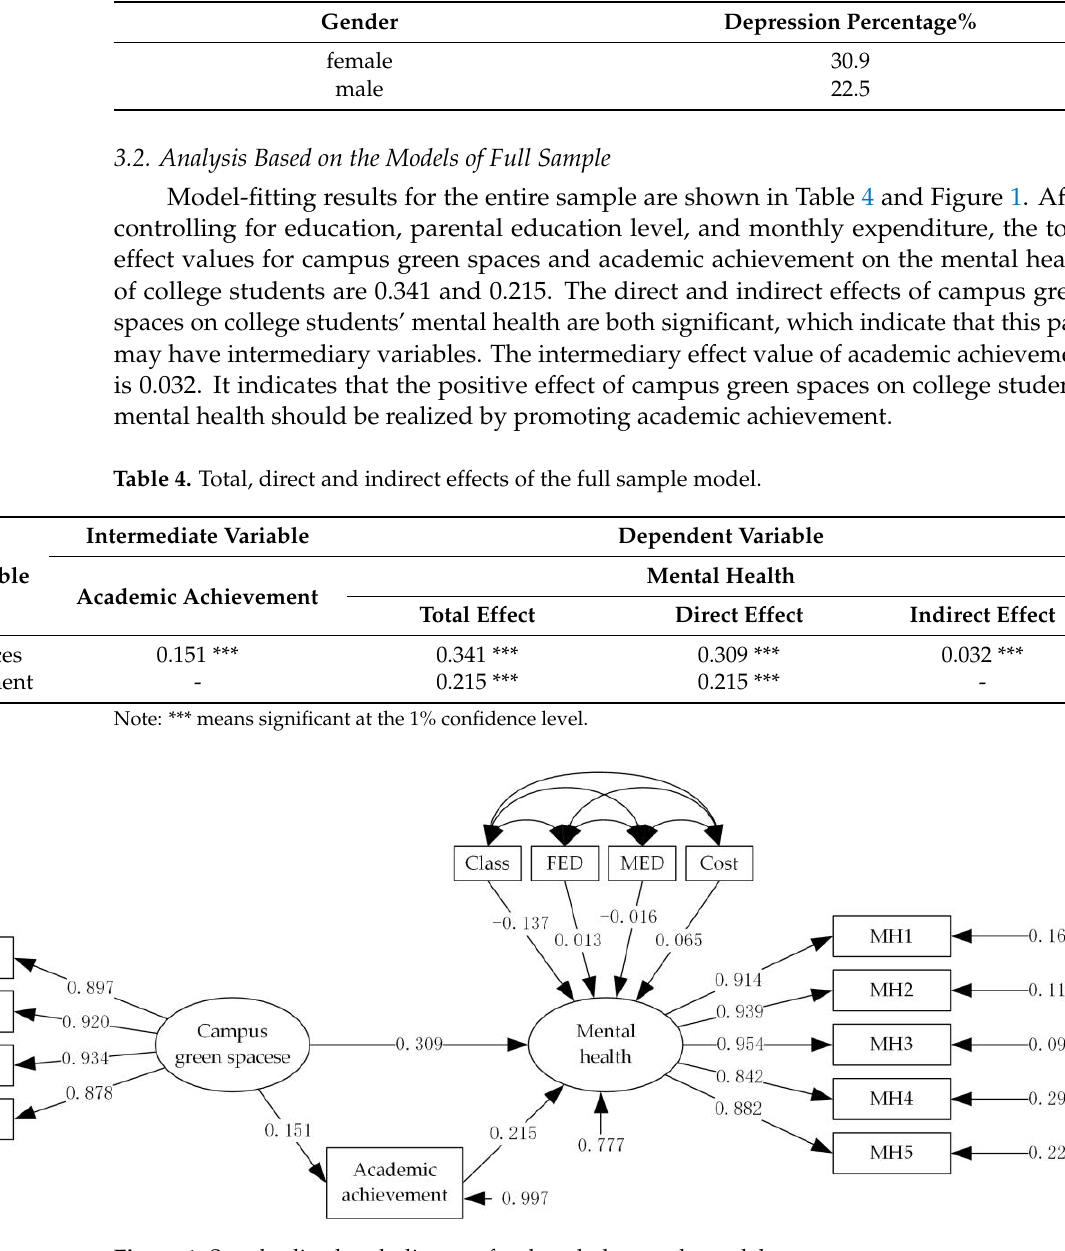
Figure 1. Standardized path diagram for the whole sample model.